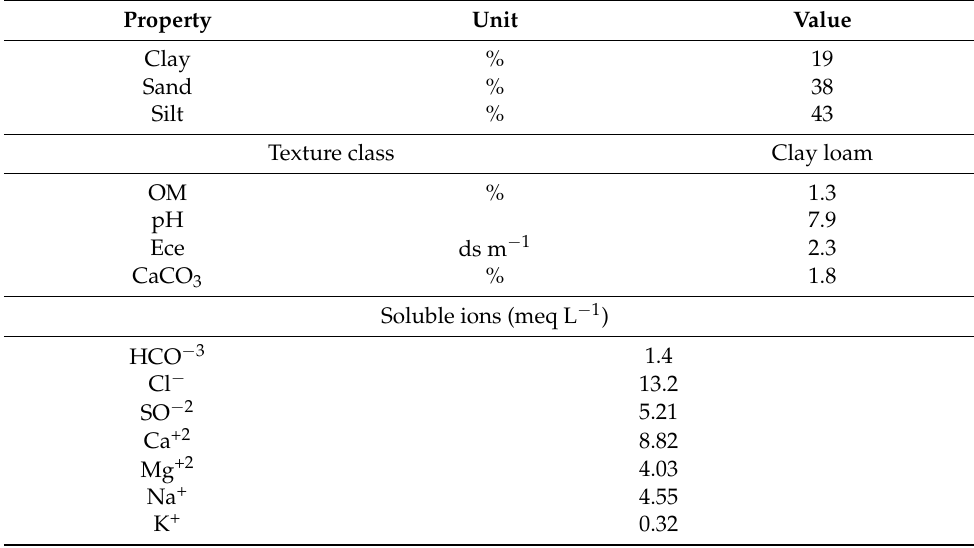
Table 1. Physical and chemical analysis of the experimental soil. Property Unit Value Clay % Sand % Silt % Texture class Clay loam